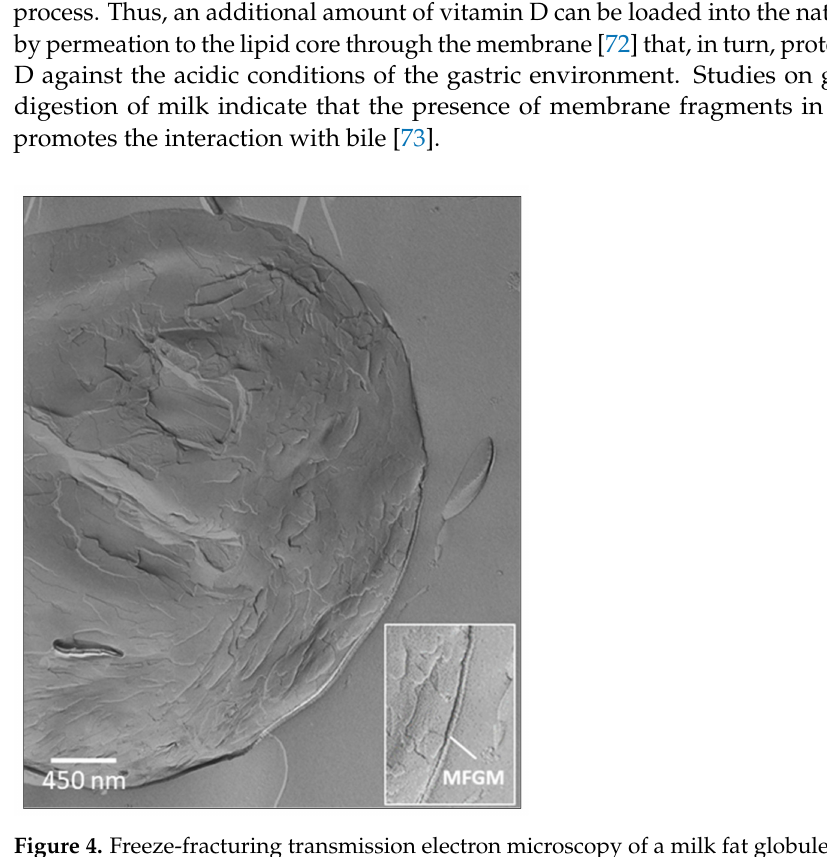
Figure 4. Freeze-fracturing transmission electron microscopy of a milk fat globule in raw milk and (box) milk fat globule membrane